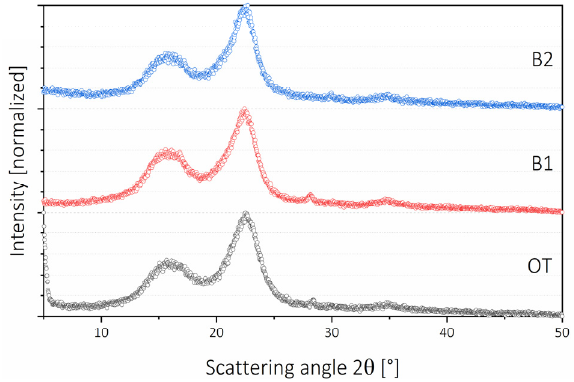
Figure 4. X-ray diffraction patterns of the elaborated nanofibers